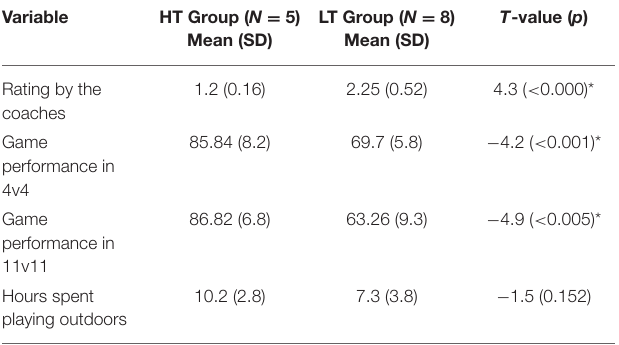
TABLE 3 | Relevant variables between HT and LT group, *significant ( p <